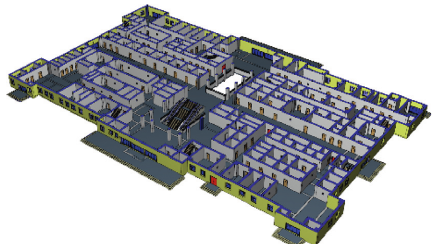
Figure 21: Fire model diagram of floor 6.